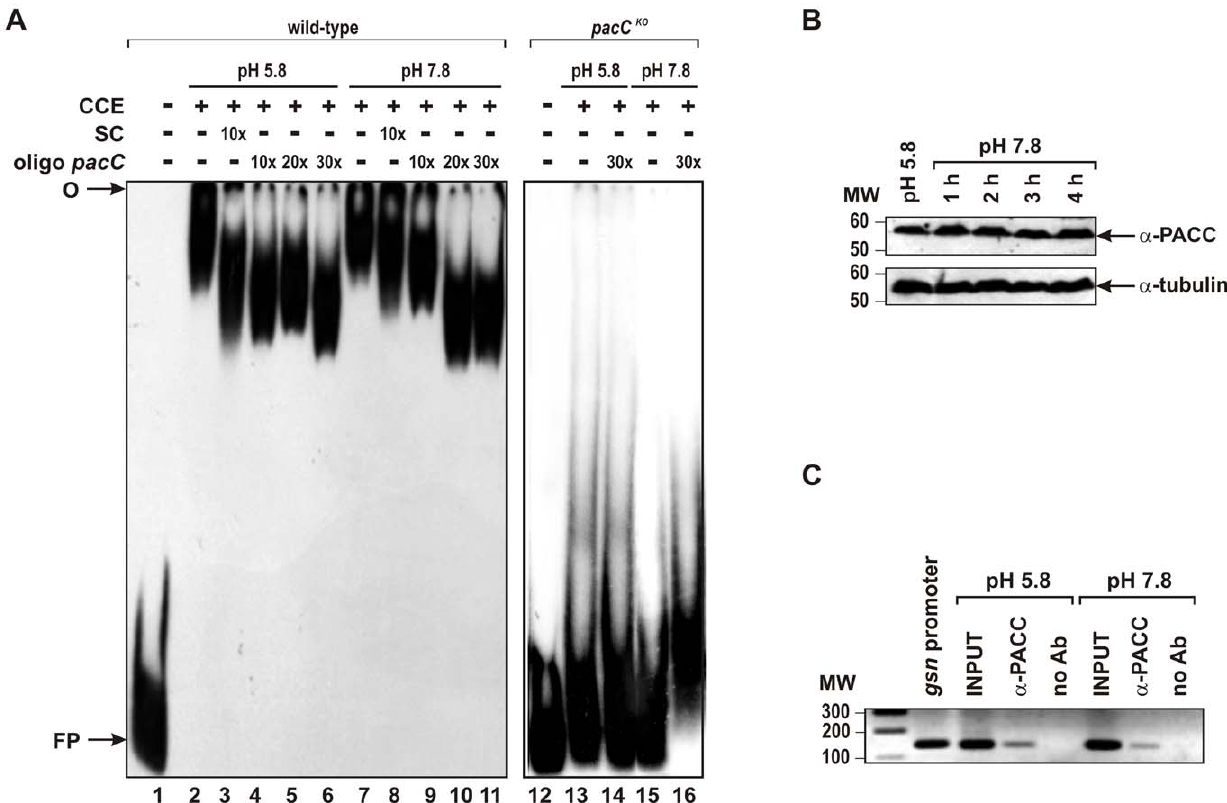
Figure 7. PACC binds specifically to the gsn promoter region in an alkaline pH-independent manner. (A) Gel shift analysis using crude cellular extracts fractionated on a Heparin-Sepharose column. Crude cellular extracts (CCE) from mycelia submitted or not to alkaline pH stress (pH 7.8) were fractionated by affinity chromatography. Left panel, a protein fraction (35 m g) exhibiting DNA-binding activity was assayed in the presence of specific competitors. Lane 1, pacC probe, no protein added. Lanes 2 and 7, proteins from pH 5.8 and pH 7.8 samples, respectively, in the absence of competitors. Lanes 3 and 8, DNA band shift in the presence of the 146 bp pacC specific competitor. Lanes 4 to 6 and 9 to 11, DNA band shifts in the presence of increasing amounts of the 27 bp DNA oligo pacC as a specific competitor. Right panel, a protein fraction (35 m g) from knocked-out strain crude cellular extract was assayed. Lane 12, pacC probe, no protein added. O, gel origin; SC, specific competitor; FP, free probe. (B) PACC shows the same molecular mass at pH 5.8 and pH 7.8. Crude cellular extracts prepared from wild-type N. crassa submitted or not to alkaline pH stress were analyzed by Western blotting using a polyclonal anti-PACC antibody. The protein a -tubulin (theoretical molecular mass 50 kD) was used as a loading control. (C) Chromatin immunoprecipitation assay using the polyclonal anti-PACC antibody. Genomic DNA samples from wild-type N. crassa submitted or not to pH stress were immunoprecipitated with the anti-PACC antibody and subjected to PCR to amplify a 146 bp DNA fragment of the gsn promoter containing the pacC motif. A plasmid construction containing the entire sequence of the gsn gene, including its 5 9 - and 3 9 - flanking regions, was used as a positive control. As a negative control, the immunoprecipitation reactions were performed without the anti-PACC antibody. L, 1 kb DNA